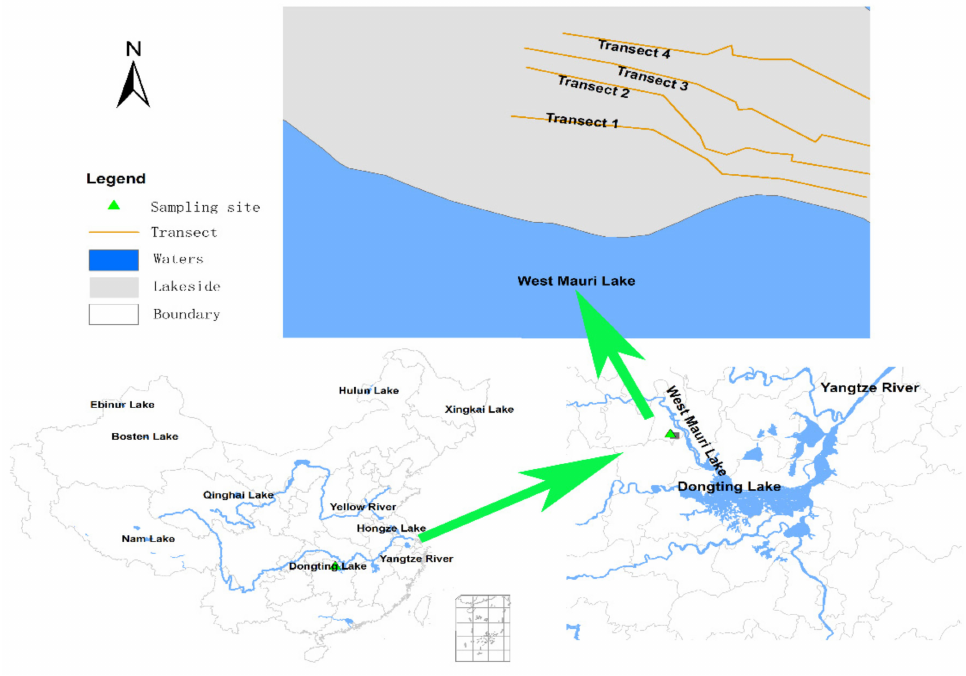
Figure 1. Schematic diagram of the four transects established along the landward lakeside of West Mauri